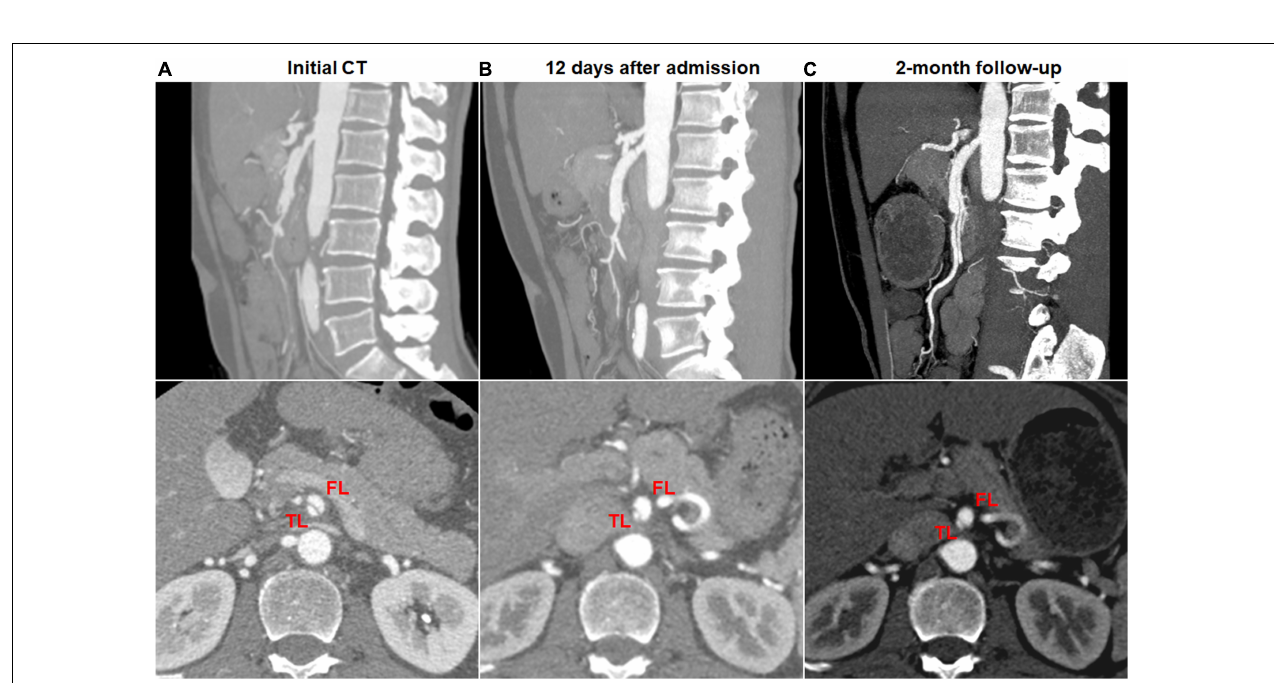
FIGURE 8 | Morphologic progression of type II spontaneous isolated superior mesenteric artery dissection on follow-up computed tomography (CT) angiography. (A) Initial CT angiography showed the patent “cul-de-sac” shaped false lumen without re-entry in a 48-year-old man. (B) Twelve days later, blind-ending false lumen was prolonged and compressed the true lumen despite symptomatic relief. (C) Two months later, the false lumen was further enlarged, and true lumen remained severely stenosed.